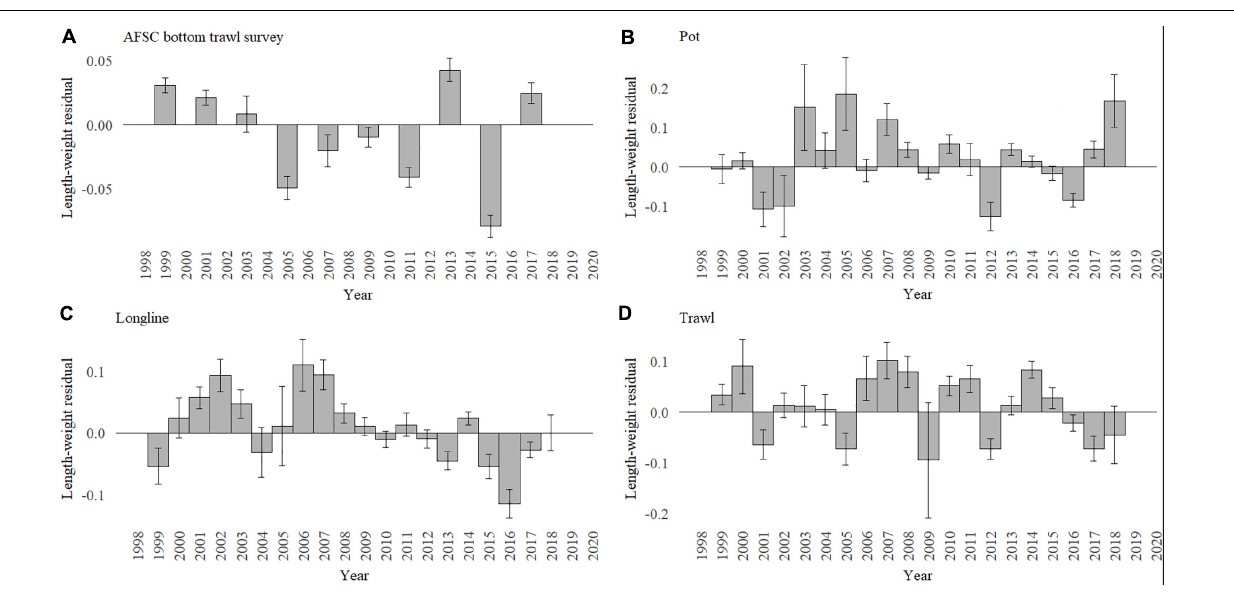
FIGURE 5 | Gulf of Alaska Pacific cod condition calculated from length-weight regression residuals for the (A) summer AFSC bottom trawl survey and (B) pot, (C) longline, and (D) trawl fisheries for January through April for each